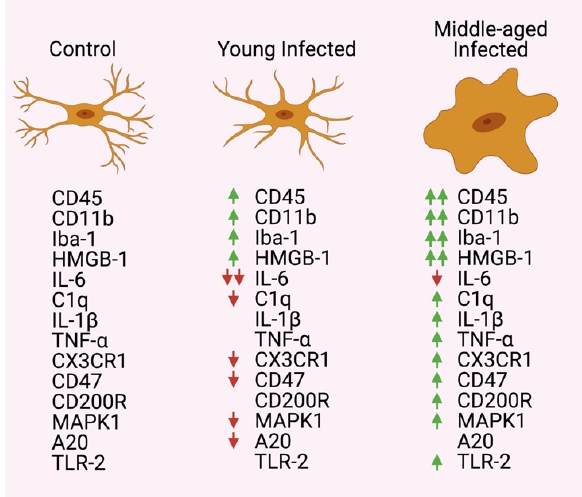
Figure 1. Expression changes between control/uninfected, young infected, and middle-aged in- fected mice. Two arrows indicate a greater increase or decrease between young and middle-aged infected groups.